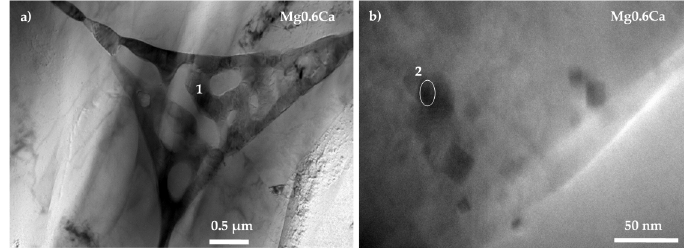
Figure 2. Transmission electron micrographs of the Mg0.6Ca alloy with locations of EDS analysis: ( a ) Mg0.6Ca 0.5 µ m and ( b ) Mg0.6Ca 0.5 nm. Table 3. Local EDS analysis (at.%) of intermetallic particles as per Figures 2 and 3.